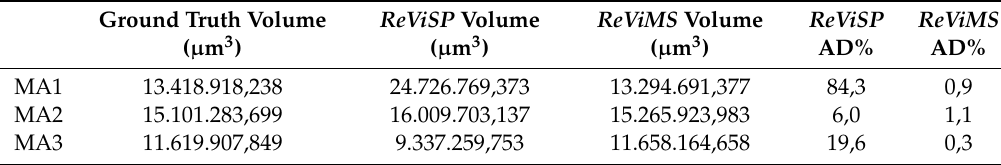
Table 1. Accuracy of ReViSP and ReViMS volume estimations.